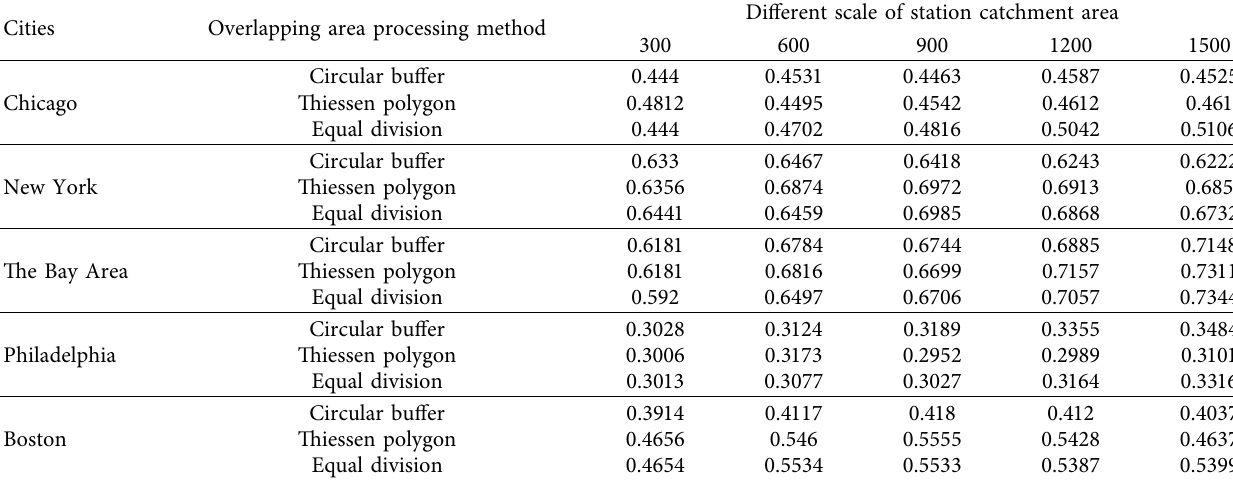
Table 6: Table of the adjusted R 2 of log-linear regression model in five